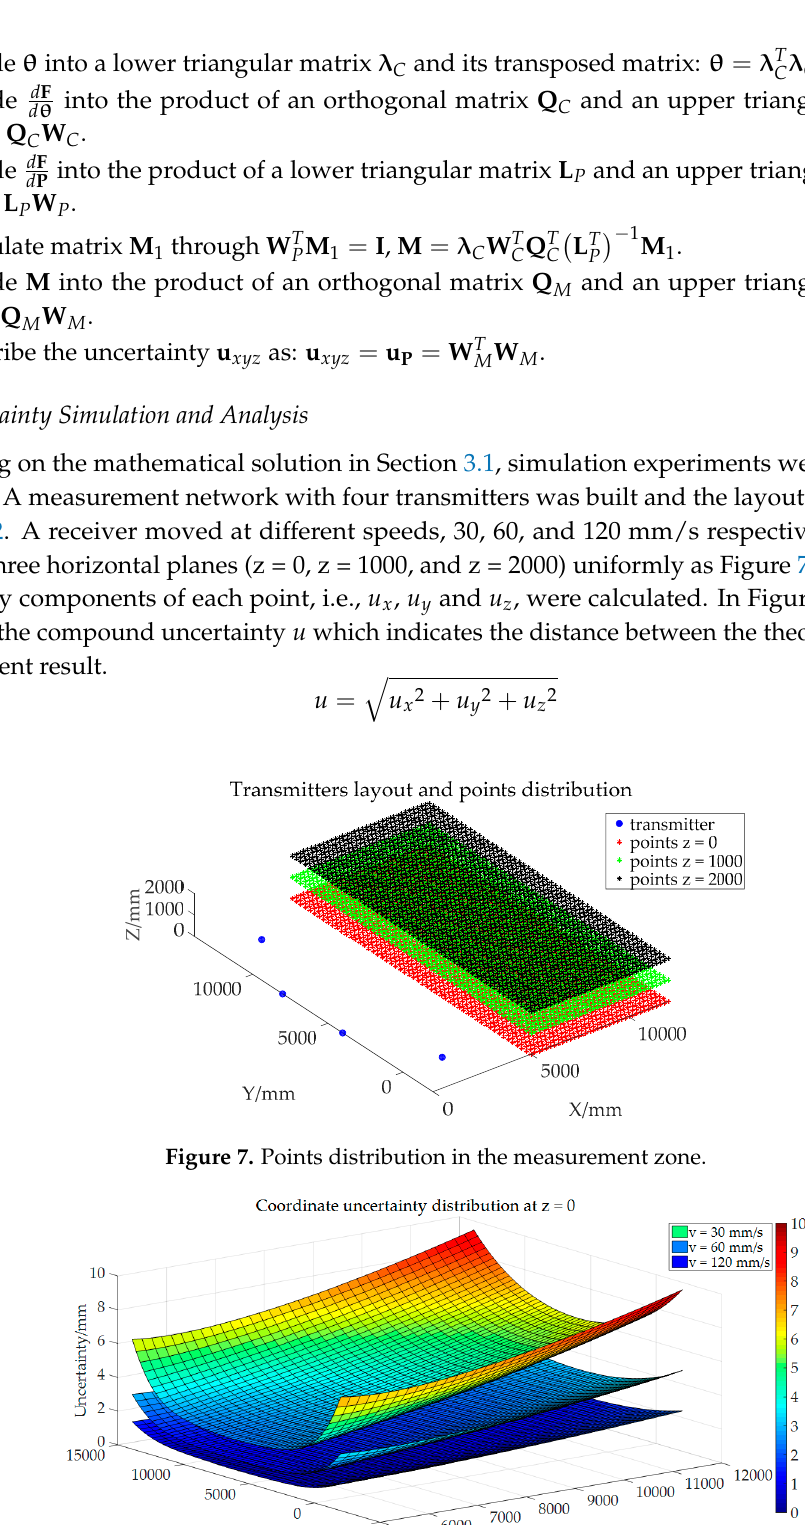
Figure 9. Coordinate uncertainty distribution of points at z = 1000.